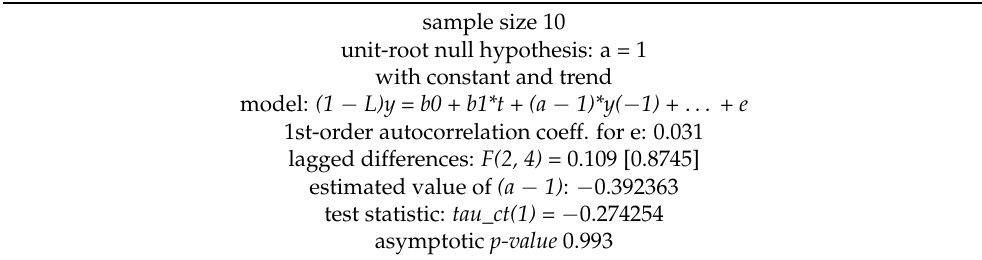
Table 3. Statistical properties of variables (ADF test) for R t including one lag of (1 − L) R t .